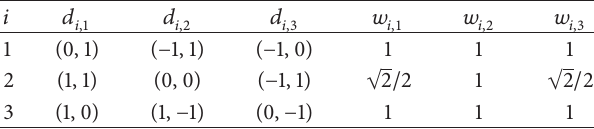
Table 2: Control vertexes and weight factors of Section